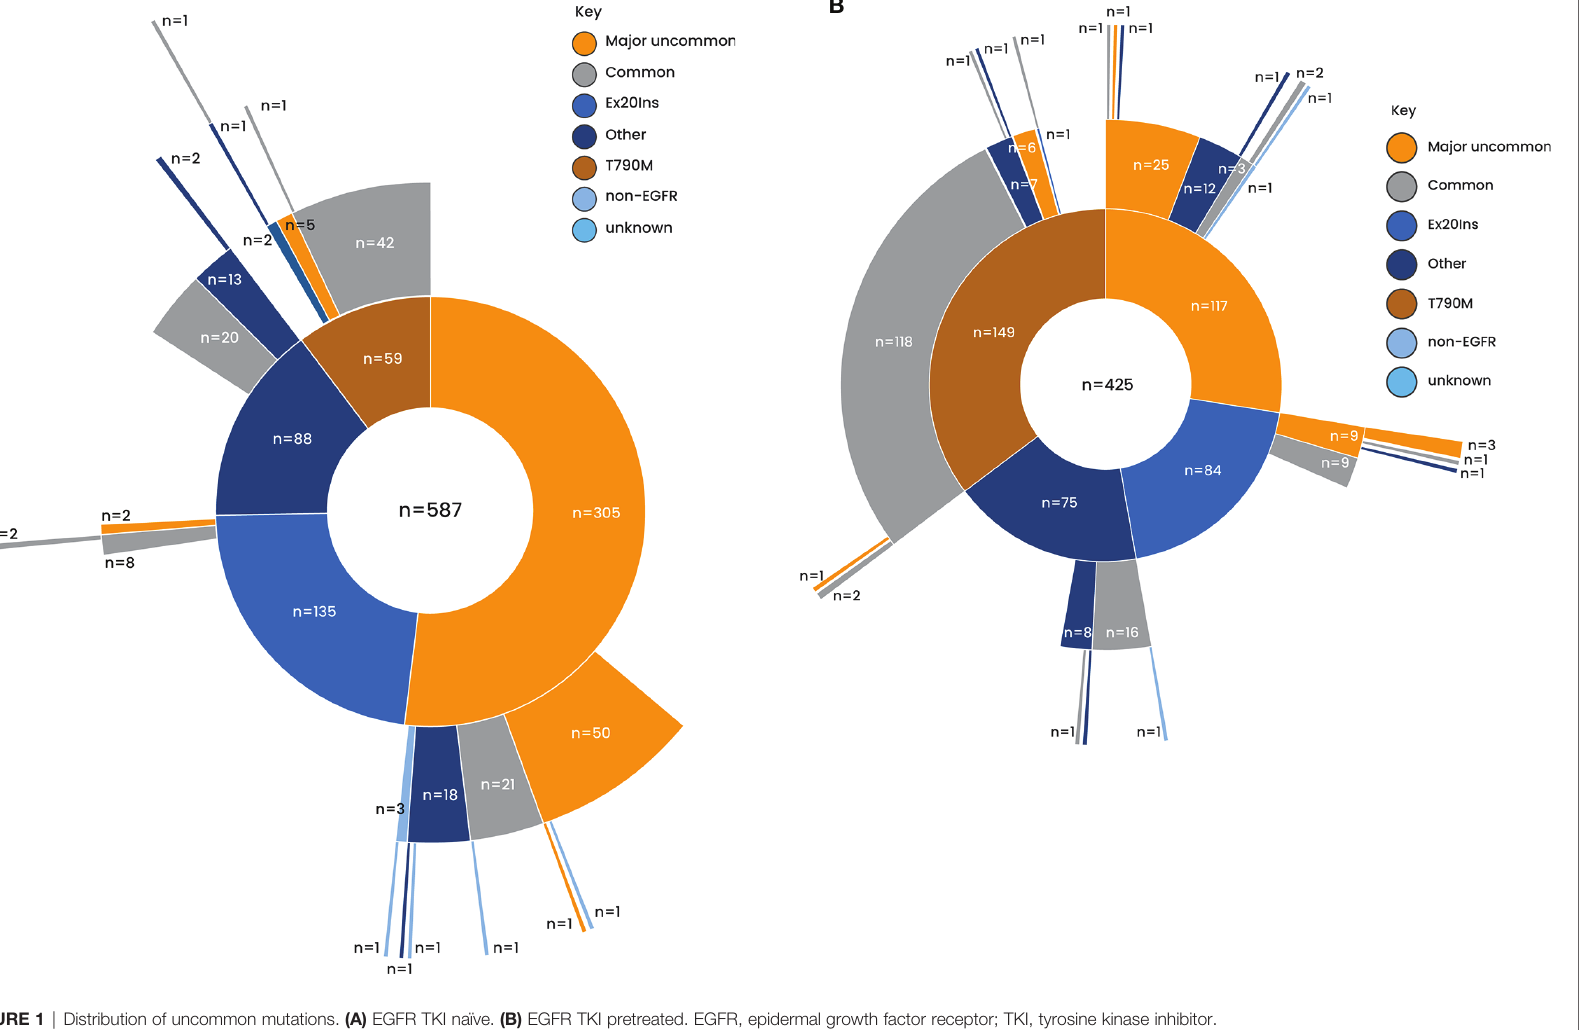
FIGURE 1 | Distribution of uncommon mutations. (A) EGFR TKI naïve. (B) EGFR TKI pretreated. EGFR, epidermal growth factor receptor; TKI, tyrosine kinase